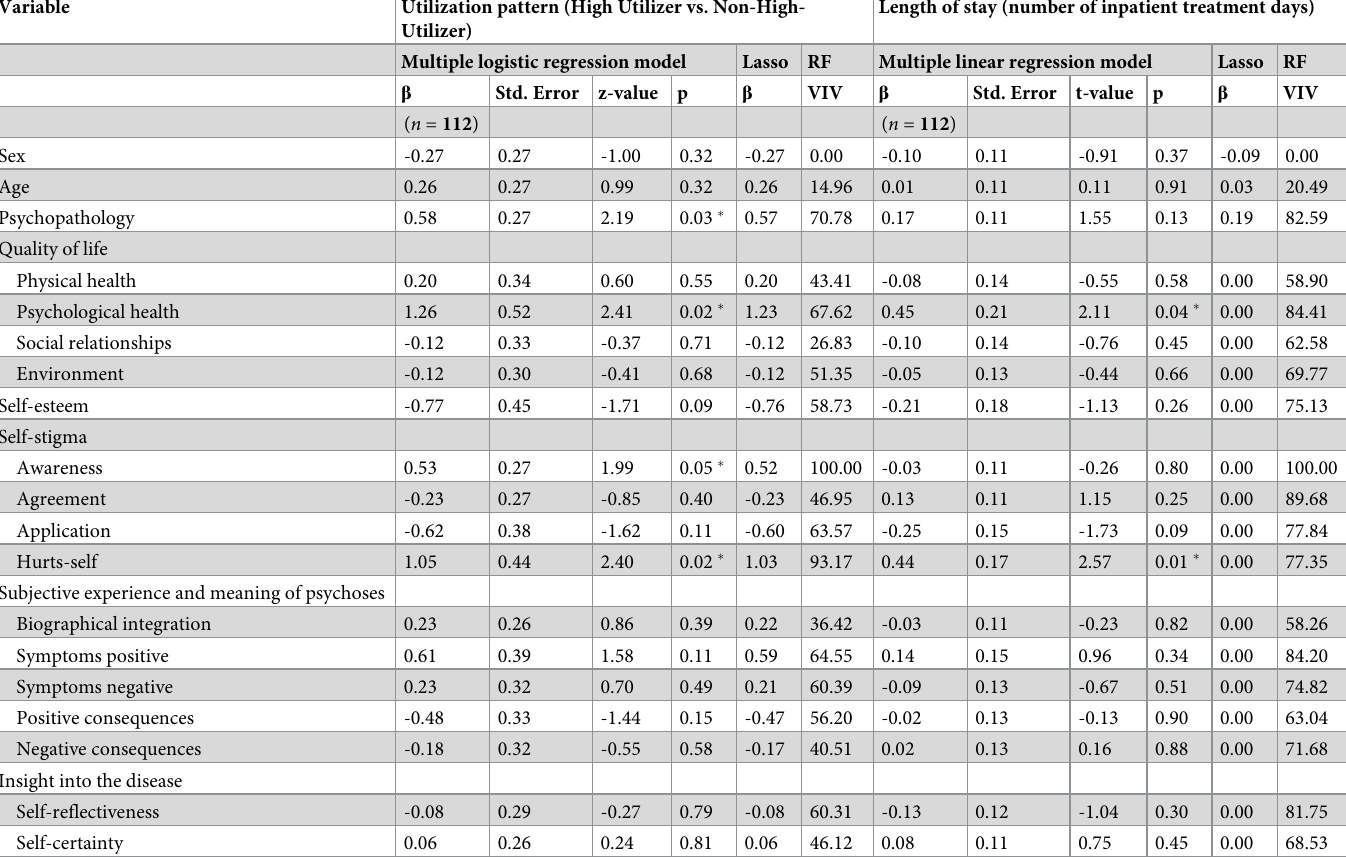
Table 2. Estimated independent effects of psychological